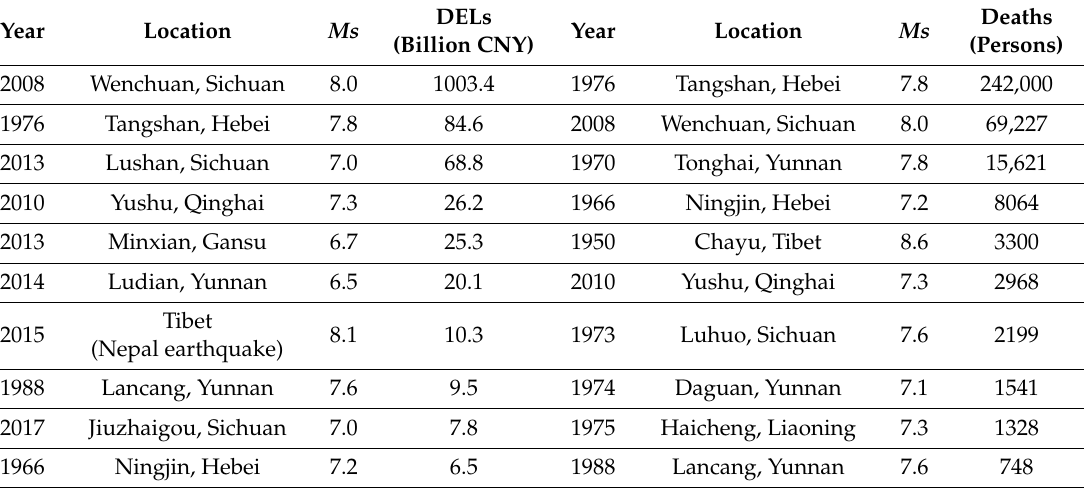
Figure 5. Frequency distribution of Ms ( a ) and cumulative distribution of earthquake-induced DELs and deaths ( b ). Table 2. The 10 most severe earthquake disasters, ranked based on their DELs and deaths, respectively, during 1950–2017.